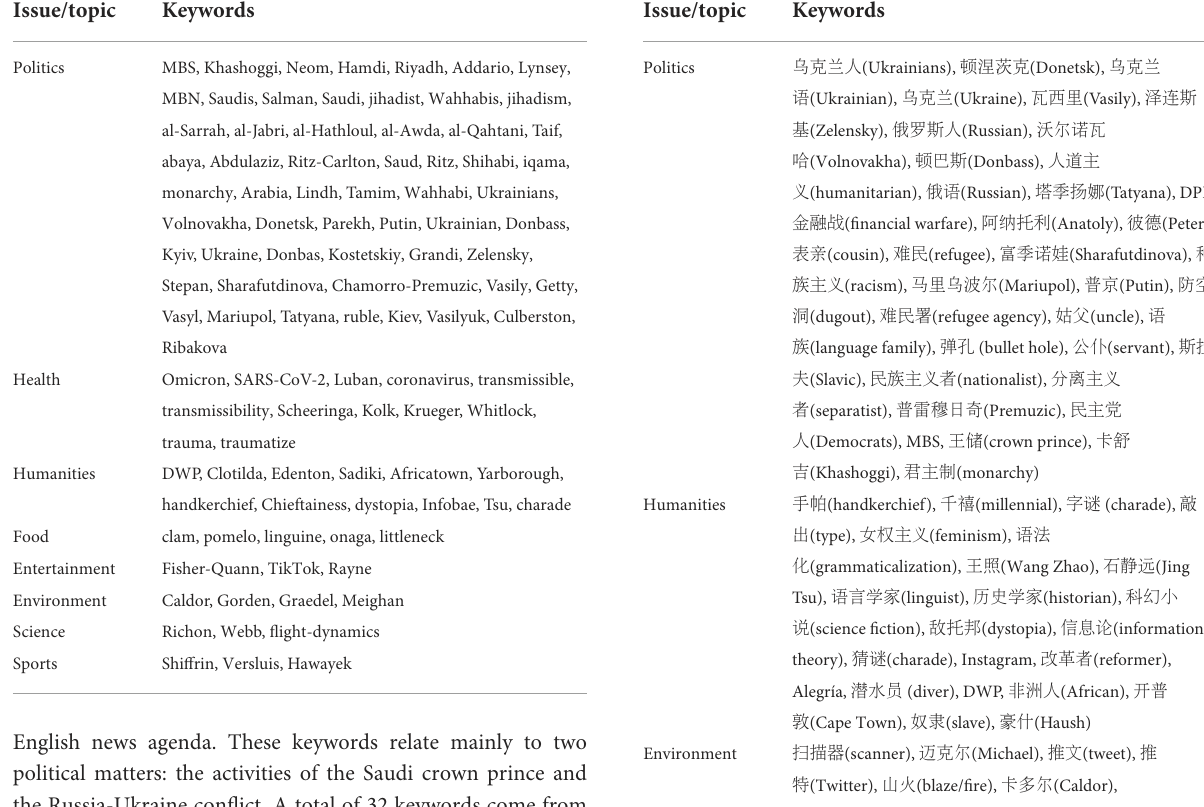
TABLE 2 Top 100 keywords in the English subcorpus. TABLE 3 Top 100 keywords in the Chinese